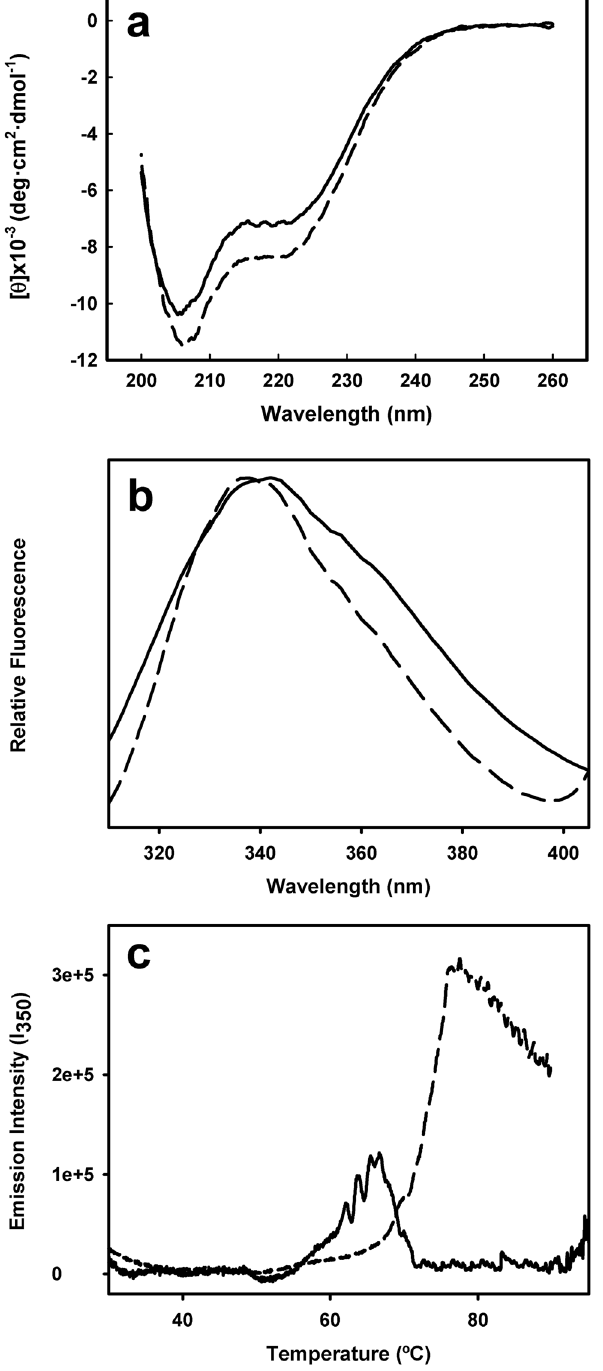
Figure 3. Effects of C1 on circular dichroism, fluorescence emission and thermal behavior of NPM mutant E C-terminal domain. A synthetic peptide corresponding to the C-terminal domain of mutant E was diluted in 50 mM phosphate buffer (pH 7.5) to a final concentration of 50 μ M. Circular dichroism spectra ( a ), Trp fluorescence emission spectra ( b ) and thermal scans ( c ) were recorded in the absence (solid line) and presence (dashed line) of 150 µ M C1. For CD experiments ( a ), C1 was prepared in ethanol, whereas for fluorescence spectroscopy ( b ) and ( c ), C1 was prepared in DMSO. In all cases, the final concentration of solvent was 1.5%